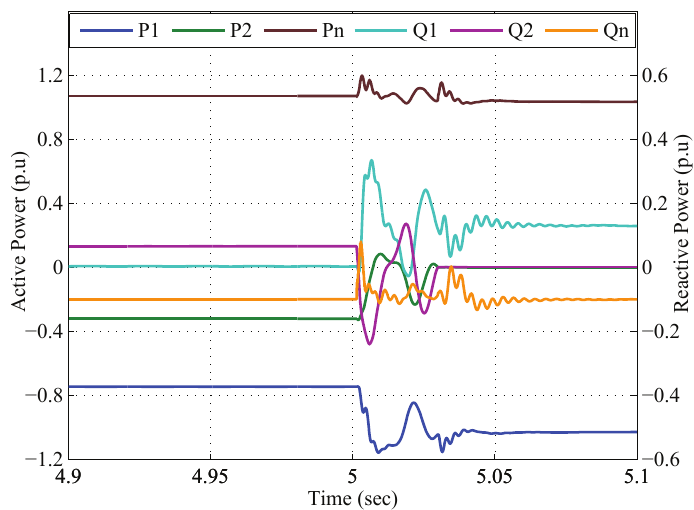
Figure 14. Power response of converter substations when the VSC-C transmission system is